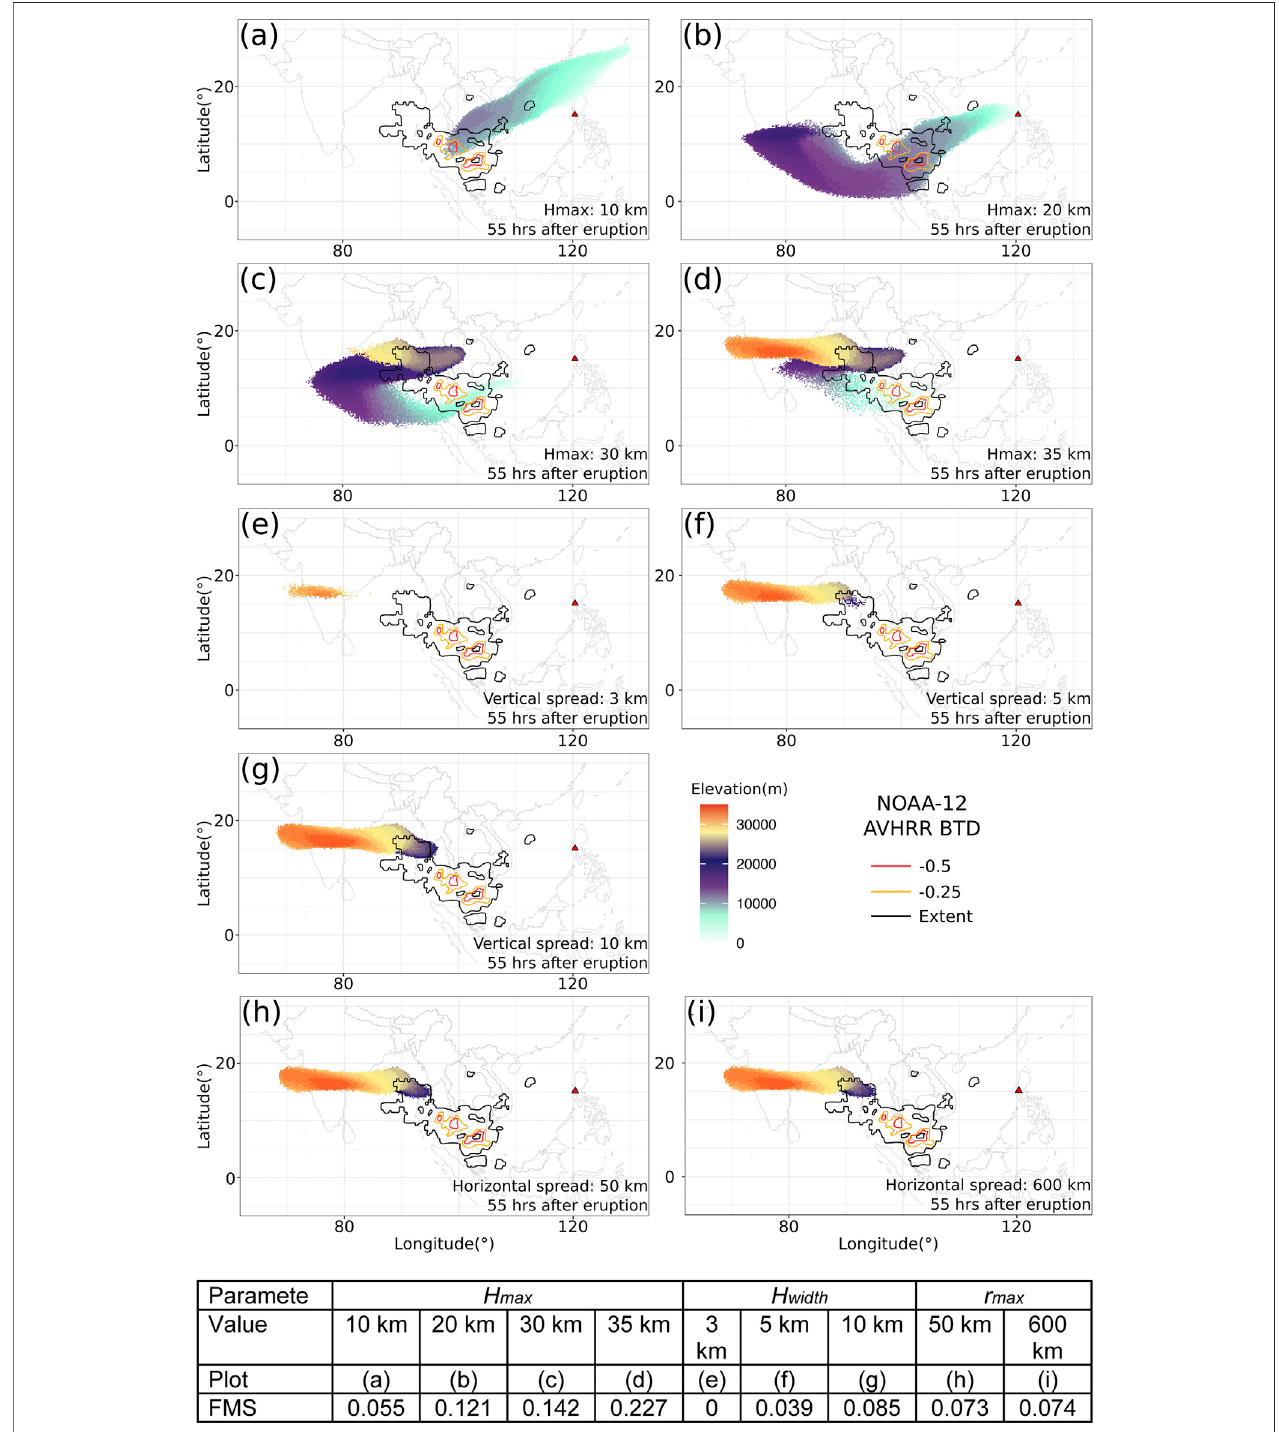
FIGURE 9 | Ash transport simulated by Puff using different initial ash clouds created according to the empirical expressions using different input parameters. All images are corresponding to 55 h after eruption (UT 199106171141). More details are in the table.